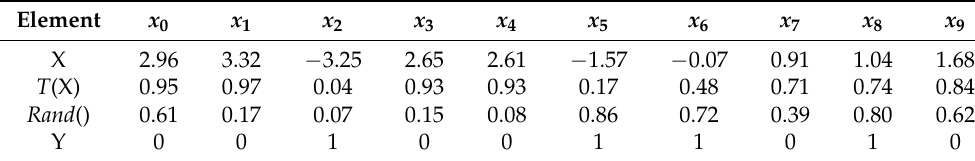
Table 2. The first mapping procedure according to S 2 transfer